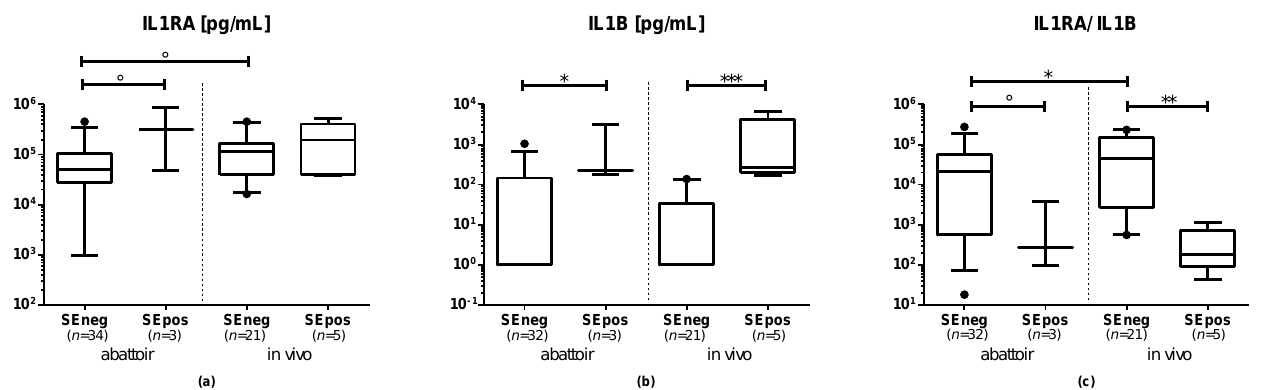
Figure 2. Concentrations of ( a ) interleukin 1 receptor antagonist (IL1RA), ( b ) interleukin 1 B (IL1B) and ( c ) the IL1RA/IL1B ratio in uterine secretions from cows sampled at the abattoir or in vivo measured via amplified luminescent proximity homogeneous assay-linked immunosorbent assay (AlphaLISA). Visualization is based on untransformed data. Boxes extend from the 25th to the 75th percentile, whiskers extend from the 5th to the 95th percentile, values beyond these upper and lower bounds are marked with black dots. The symbols indicate the results of pairwise comparisons of log-transformed data as follows: ° = p < 0.1; * = p < 0.05; ** = p < 0.01; *** = p < 0.001.